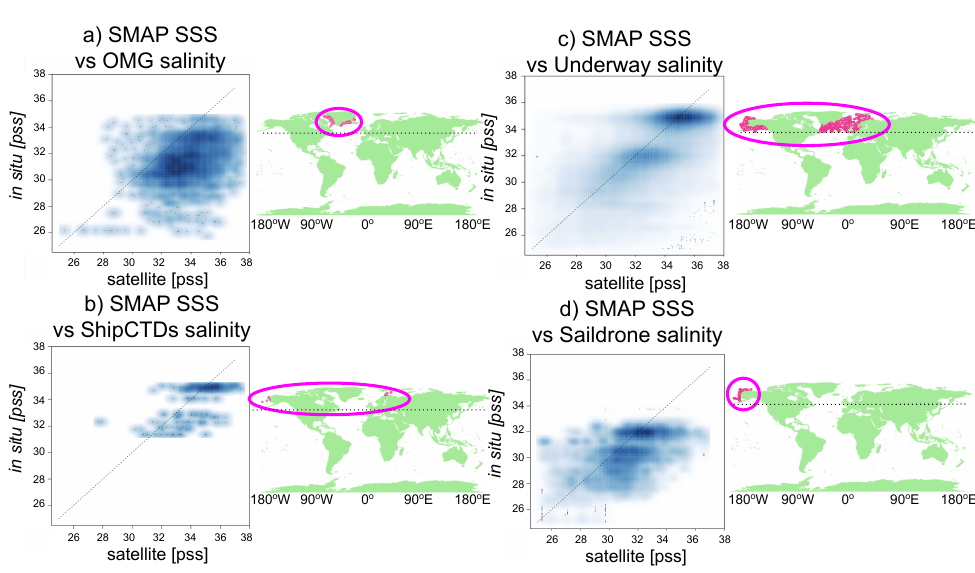
Figure 1. SMAP Level-2 skin SSS for April 2015 to December 2020 (abscissa) sampled within 50 km and 3.5 days of all in-situ observations in the top-5 m versus the bulk SSS from in-situ observations in the top-5 m (ordinate) from the Oceans Melting Greenland (OMG— panel a ), ship-based CTD hydrography (panel b ), Underway (panel c ), and Saildrone (panel d ) campaigns. The darker the shade of blue, the greater the number of points in the scatterplots; outliers are shown with single black dots. Additionally shown next to each scatterplot are the locations where the comparisons between the SMAP SSS product and the in-situ observations are made (pink dots, regions circled); the dashed black line indicates where 55 ◦ N